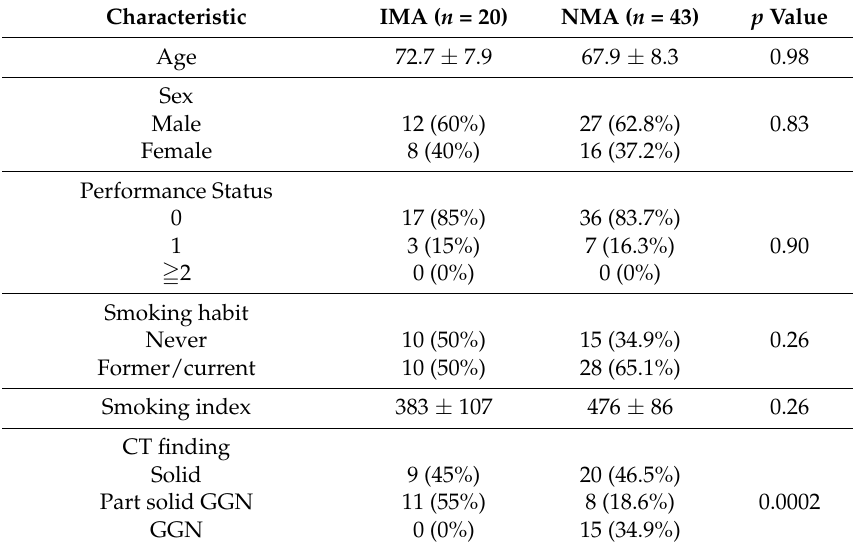
Table 1. Patient